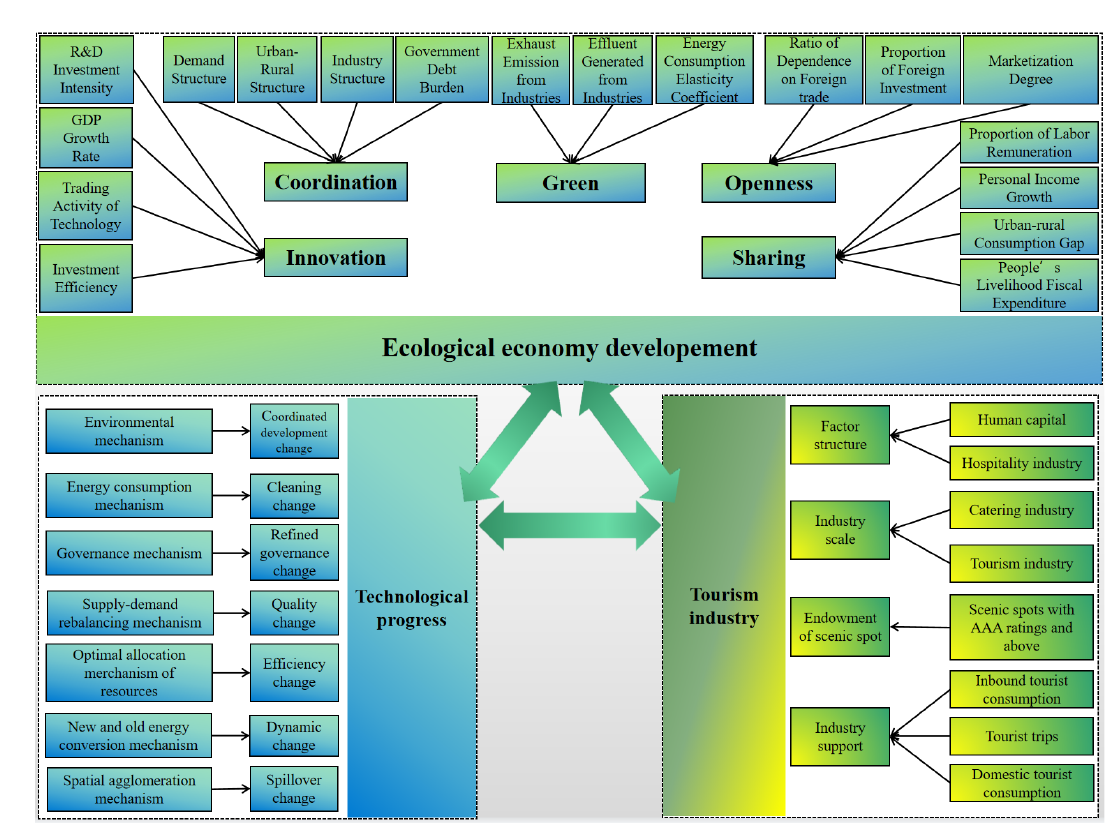
Figure 1. Influencing mechanism framework of the tourism industry, technological progress, and ecological economy development (source: made by